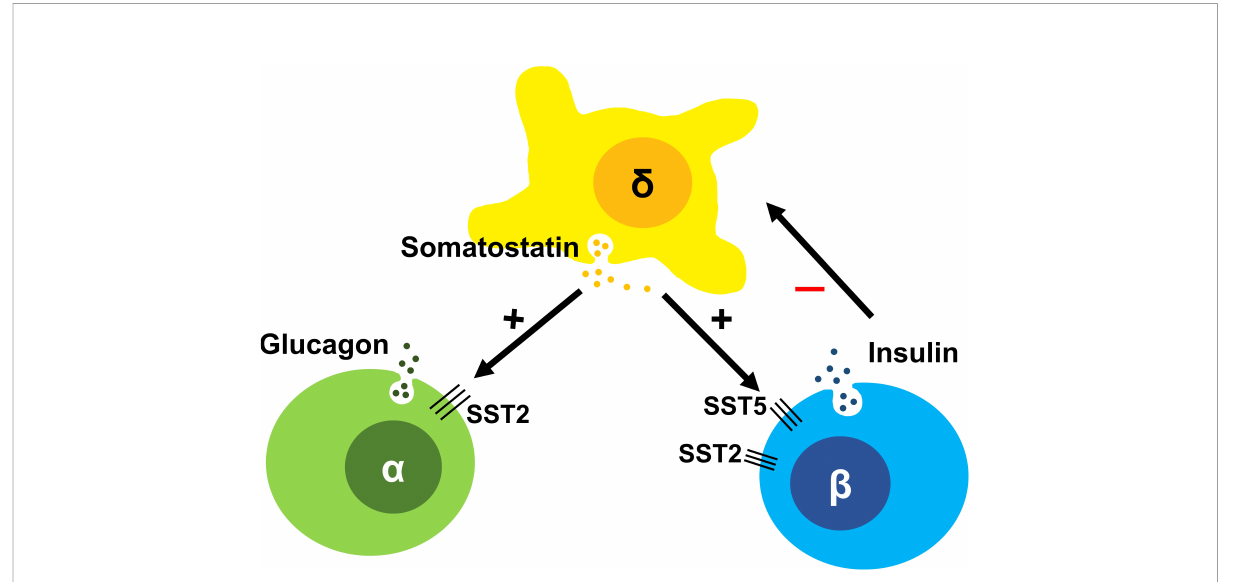
FIGURE 1 The somatostatin induced inhibitory paracrine regulation of the islet system comprising of a , b and d -cells, with d -cells inhibiting sustained insulin secretion and so preventing hyperinsulinism in the normal